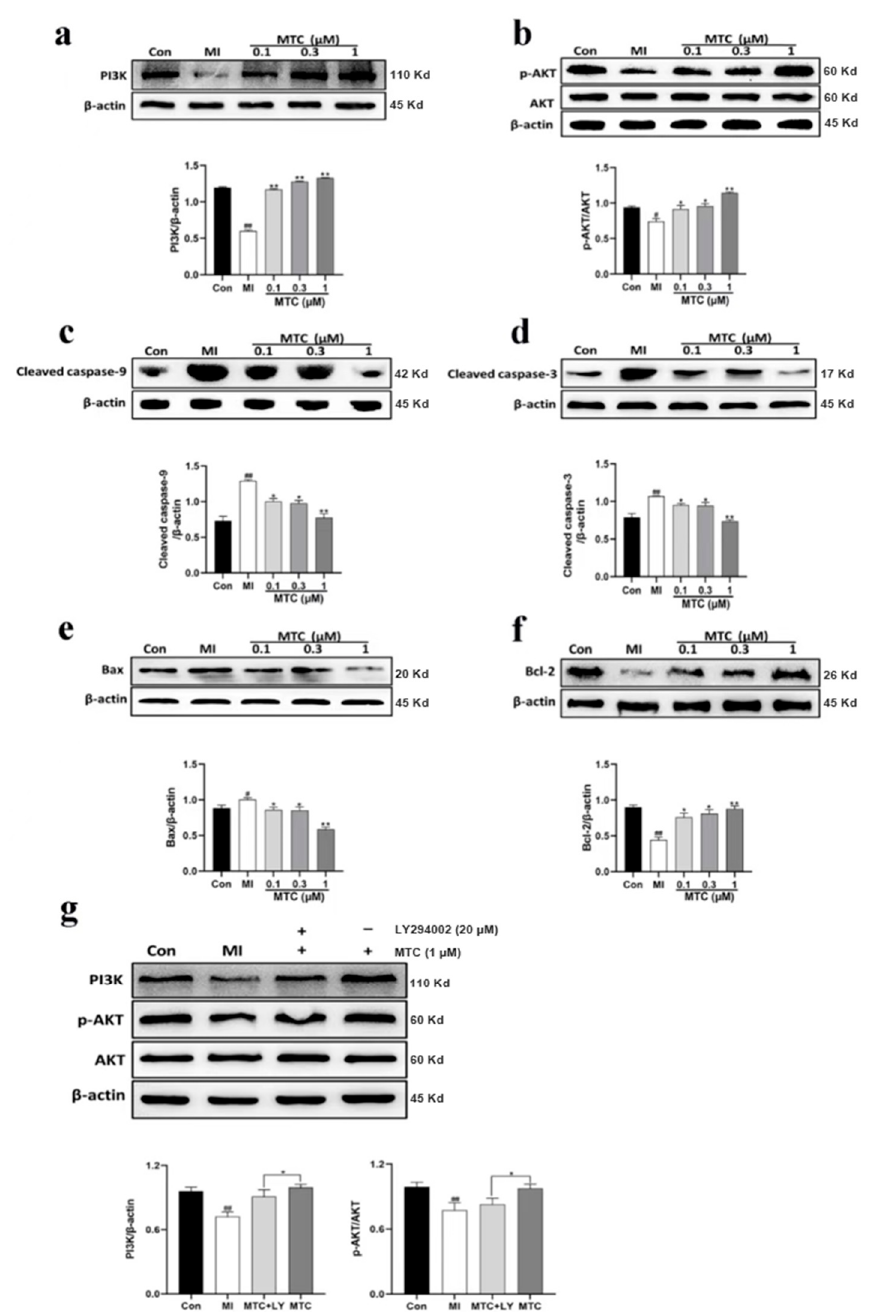
Figure 4. The expression of PI3K, p-AKT, cleaved caspase-9, cleaved caspase-3, Bax and Bcl-2 protein in PC12 cells was induced by ischemia-reperfusion for 24 h after MTC treatment. ( a ) Western blot analysis showed that the levels of PI3K activated by MTC post-treatment; ( b ) Western blot anal- ysis showed that the levels of p-AKT activated by MTC post-treatment; ( c ) Western blot analysis showed that the levels of cleaved caspase-9 was inhibited by MTC post-treatment; ( d ) Western blot